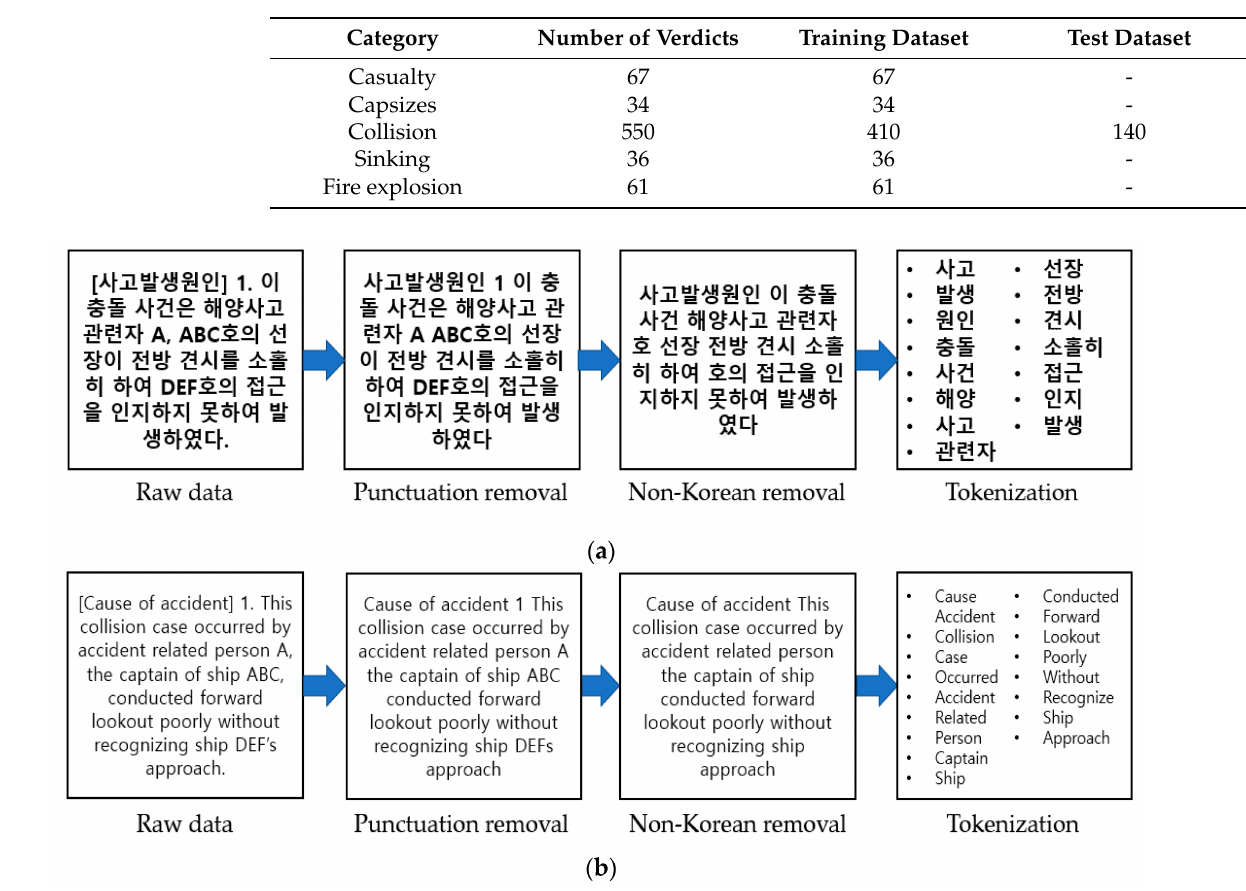
Table 1. Collected verdict data.